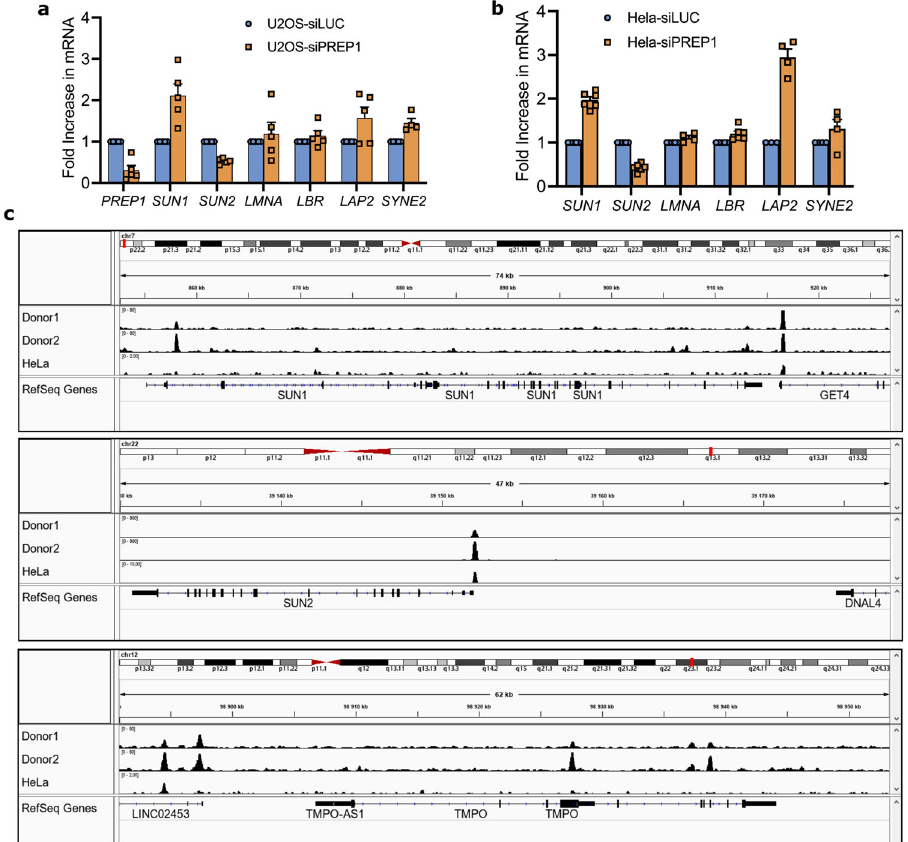
Fig. 2 Transcriptional regulation of SUN1 , SUN2 and LAP2 by PREP1. a , b Bar graph shows transcript levels of SUN1, SUN2, LMNA, LBR, LAP2 and SYNE2 in control (siLUC) and PREP1 depleted (siPREP1) U2OS cells ( a ) or HeLa cells ( b ) assessed by qPCR. Error bars show mean ± SEM of three or more independent experiments. c PREP1 binding pro fi le (Big Wig fi les) to the loci of human SUN1 (upper panel), SUN2 (middle panel) and TMPO/LAP2 (bottom panel) genes in the IGV genome browser are shown. The top bar shows the entire human chromosome 7 (upper panel), human chromosome 22 (middle panel) or human chromosome 12 (bottom panel) with the various chromosomal positions (p and q). The lower corresponding rows show the binding pro fi les of PREP1 on SUN1 (upper panel), SUN2 (middle panel), or TMPO ( LAP2 , bottom panel) in Chip-seq experiments using cardiac mesenchymal stromal cells from two human donors and HeLa